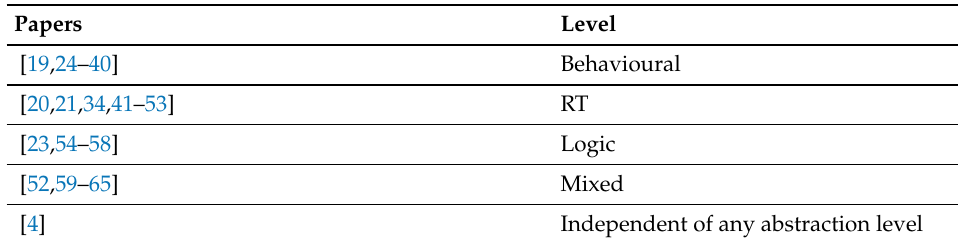
Table 2. Categorization of papers into abstract levels.